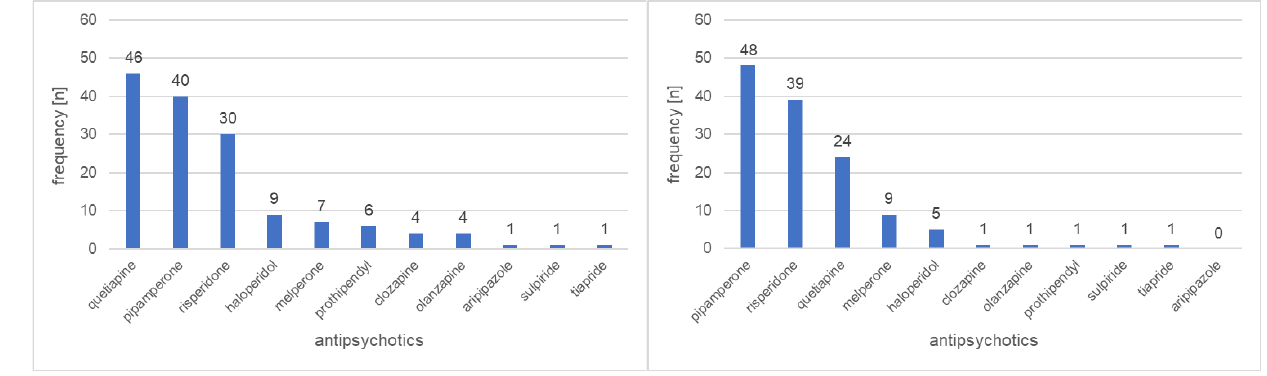
Figure 2. Young-old group; aged 74 – 84 years ( n = 113). Old-old group; aged 85 – 100 years ( n = 93).